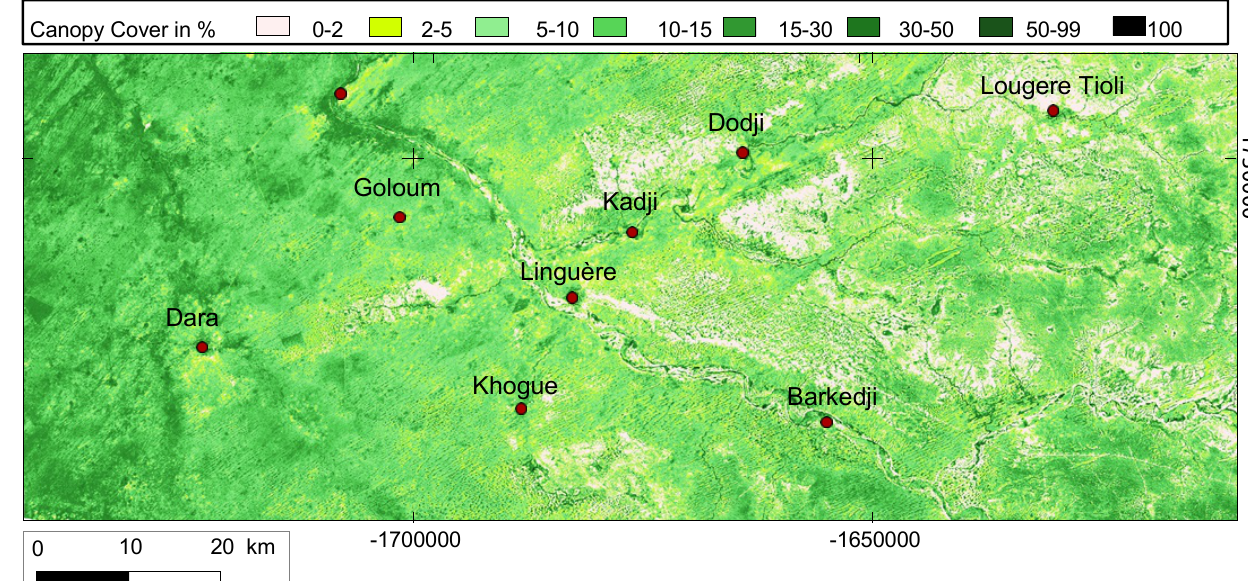
Figure 6. Modeled canopy cover for the whole study area. The area represents the square in Figure